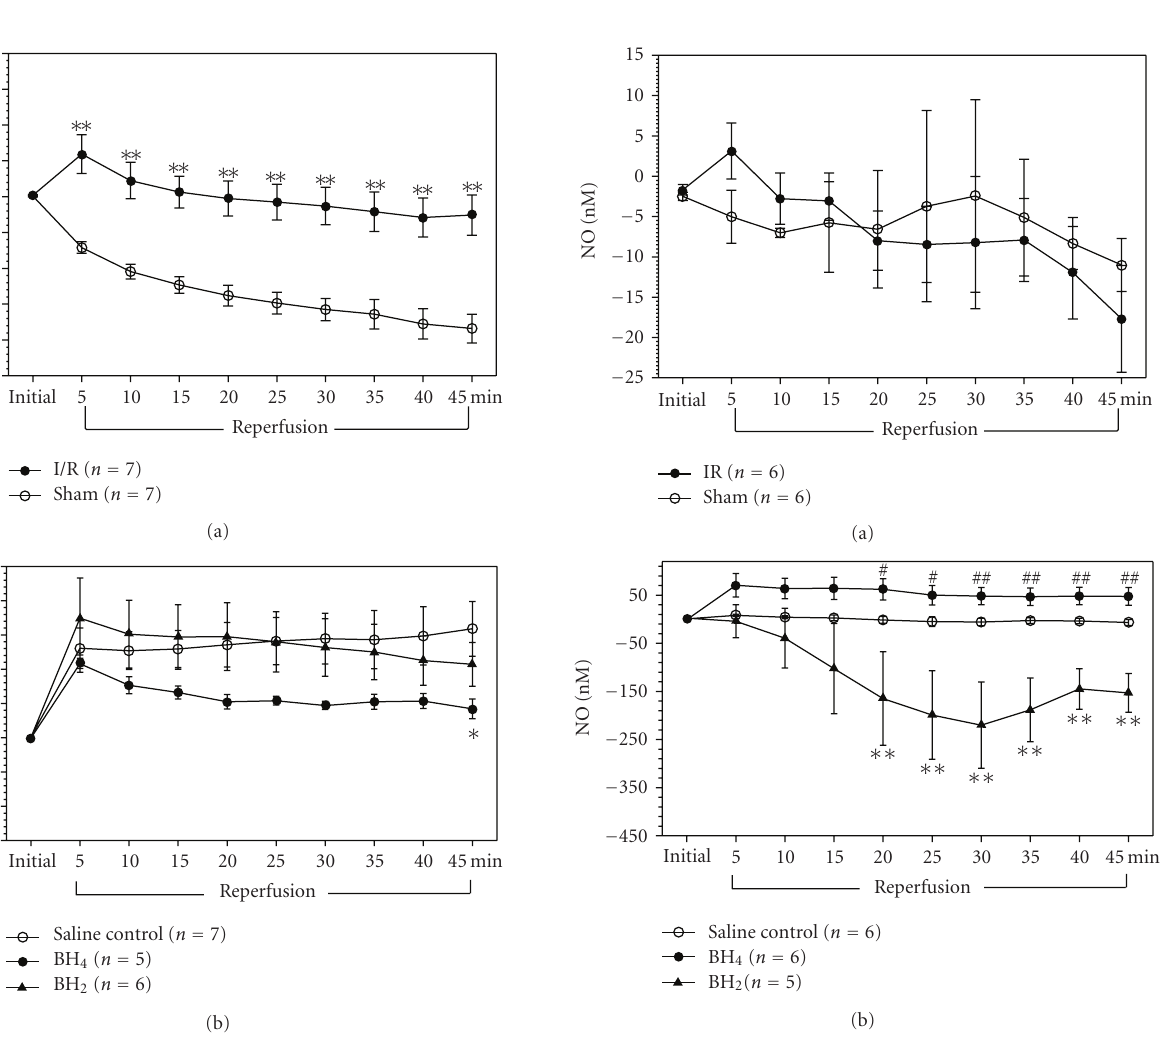
( P < . 05) to 45 minutes reperfusion ( P < . 01)